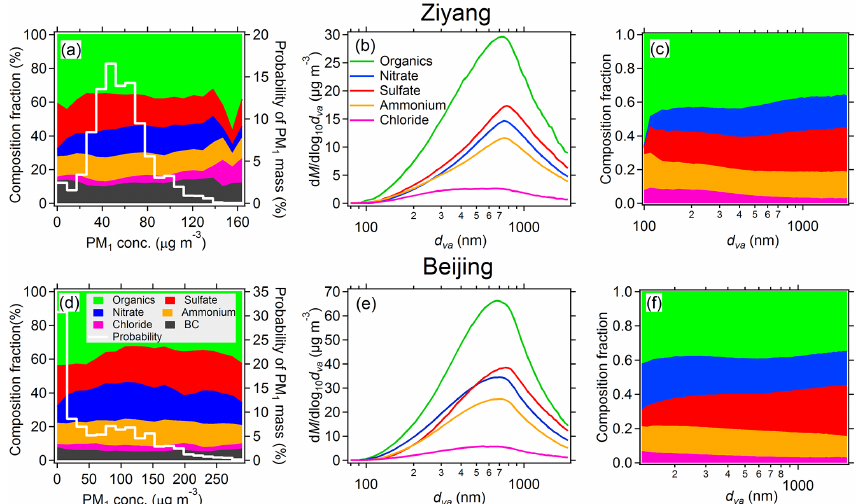
Figure 3. Comparison of the results between Ziyang site (upper) and an urban site in Beijing (lower) near to wintertime. (a, d) Fractions of main chemical components in PM 1 as a function of PM 1 mass concentrations (left) and the probability density of PM 1 mass concentrations (right); (b, e) Average size-resolved mass concentration distributions of chemical species in submicron aerosols; (c, f) Fractions of chemical species in total NR-PM 1 as a function of vacuum aerodynamic size ( d va )